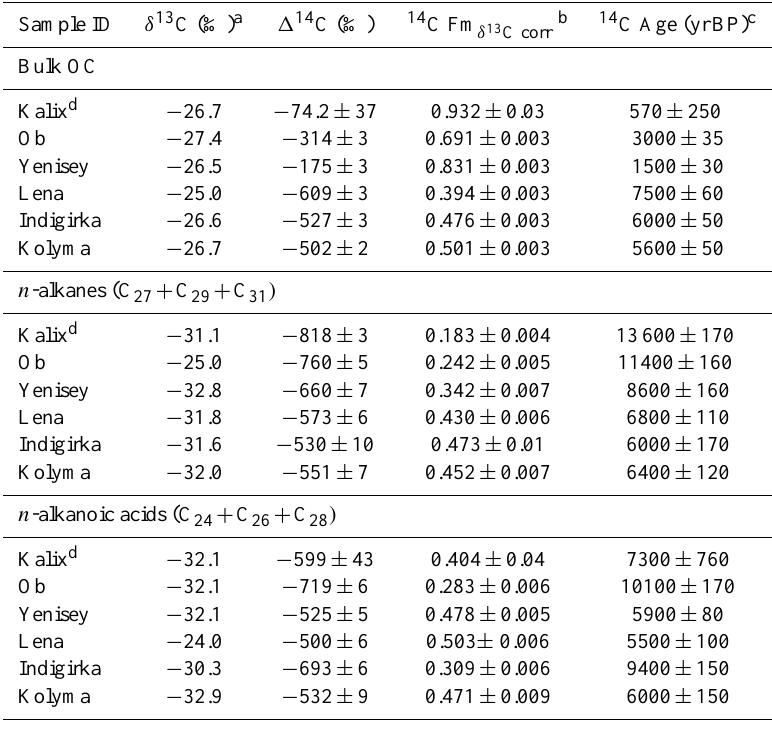
Table 2. Carbon isotopic composition and age of bulk surface sedimentary organic carbon, high-molecular-weight (HMW) n -alkanes (C 27 +C 29 +C 31 ) and HMW n -alkanoic acids (C 24 +C 26 +C 28 ) in surface sediment of Eurasian Arctic River